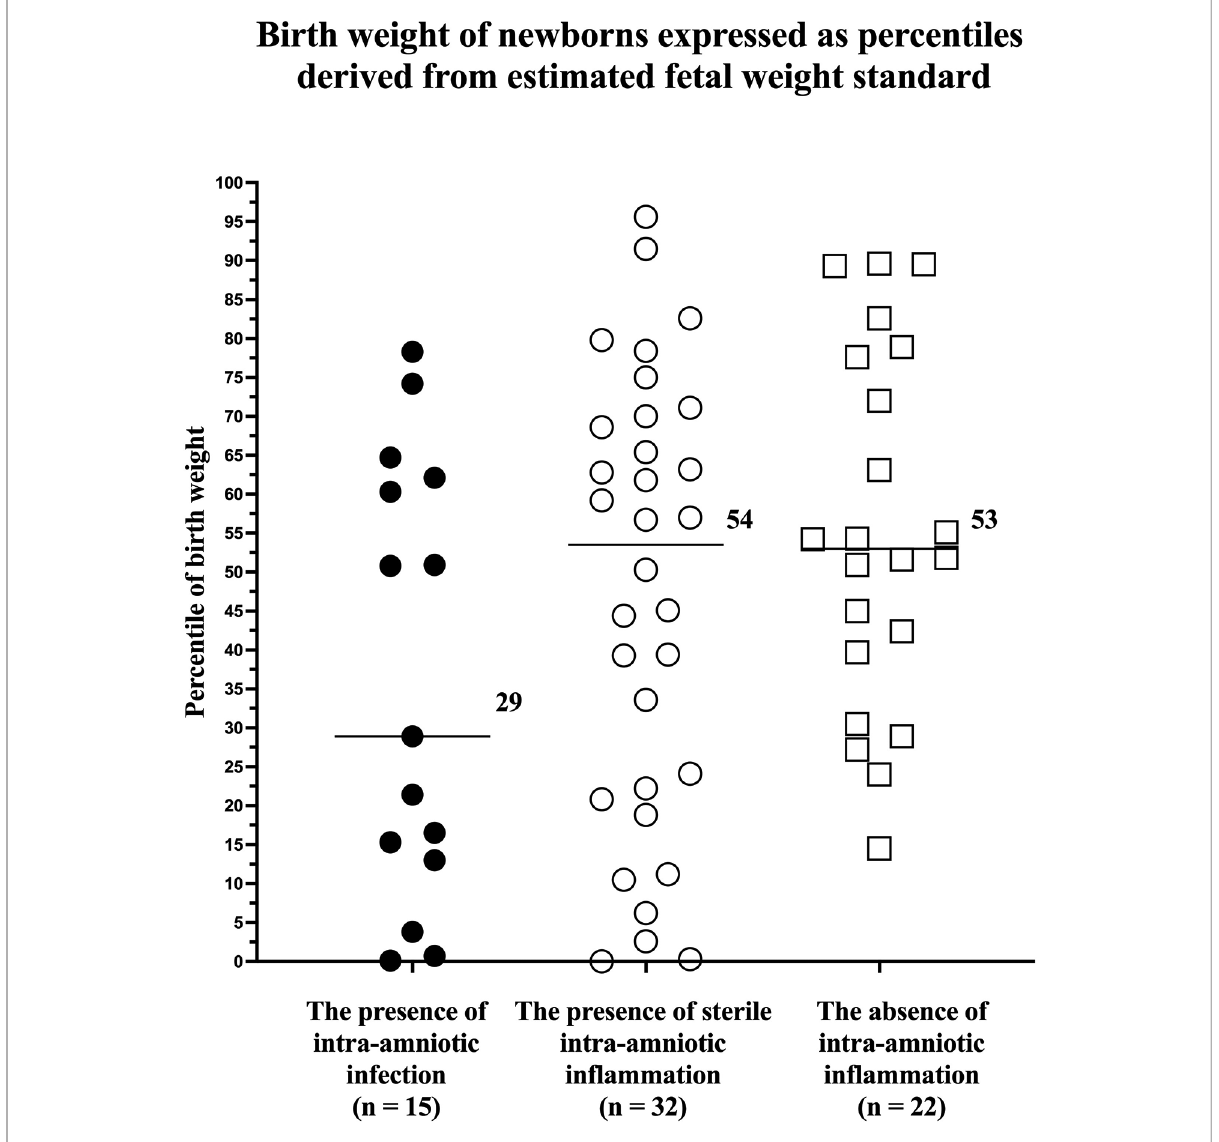
FIGURE 1 Comparison of newborn birth weight, expressed as percentiles derived from estimated fetal weight standards, from pregnancies with preterm labor with intact membranes prior to a gestational age of 35 weeks with the presence of intra-amniotic infection, presence of sterile intra-amniotic in fl ammation, and absence of intra-amniotic in fl ammation. Medians are